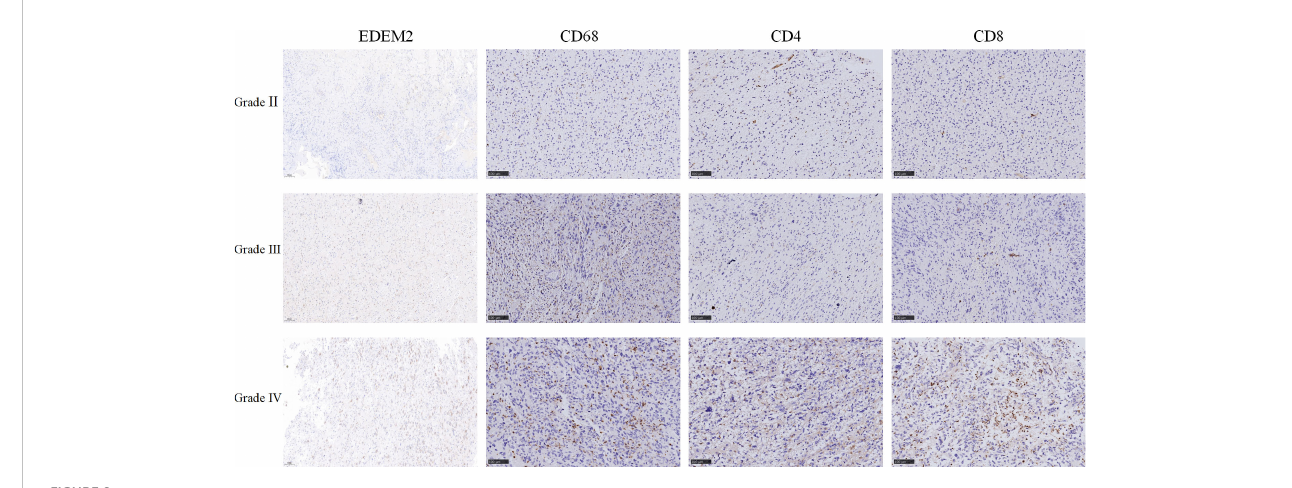
FIGURE 9 Immunohistochemical picture of three different grades of clinical samples.